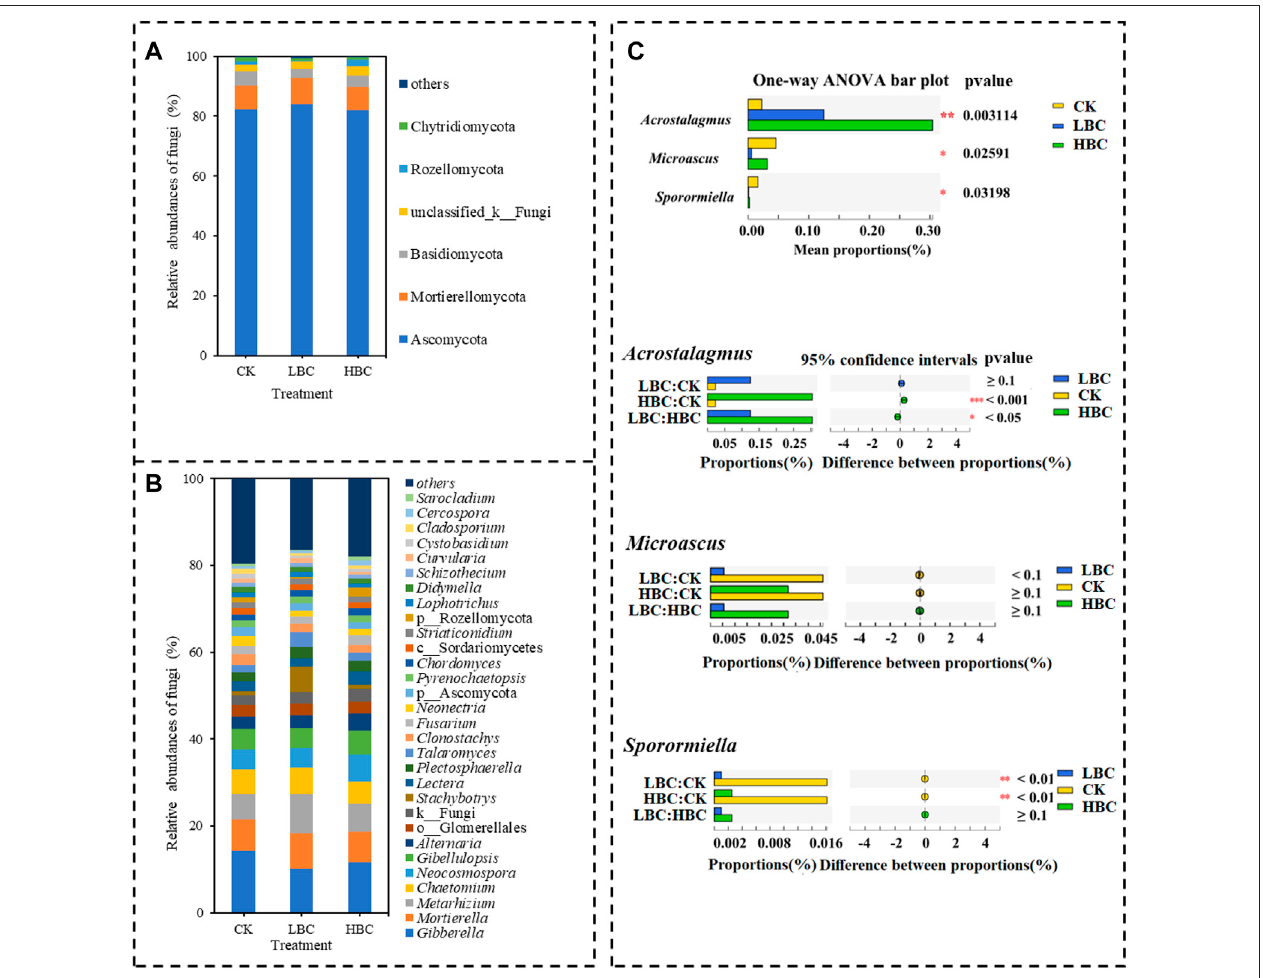
FIGURE 3 | Fungal community of the coastal saline soil with or without biochar amendment. The relative abundance of fungal phyla (A) and genera (B) , and differentiallyabundantfungalgenera (C) accordingtoone-wayANOVA.Othersrefertobacteriaandfungiwitharelativeabundancelowerthan1%.Thesigni fi cances(n= 6) are marked withasterisks(**0.01 ≤ p < 0.05, **0.001 ≤ p < 0.01, *** p < 0.001).CK, soil without biochar amendment; LBC, soil amended withalow amount ofbiochar at 18 t/ha; HBC, soil amended with a high amount of biochar at 36